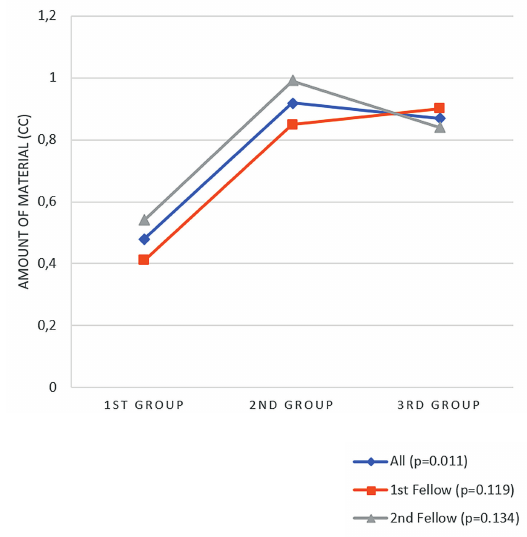
Figure 2 - variation in mean material injected per ureter unit according to